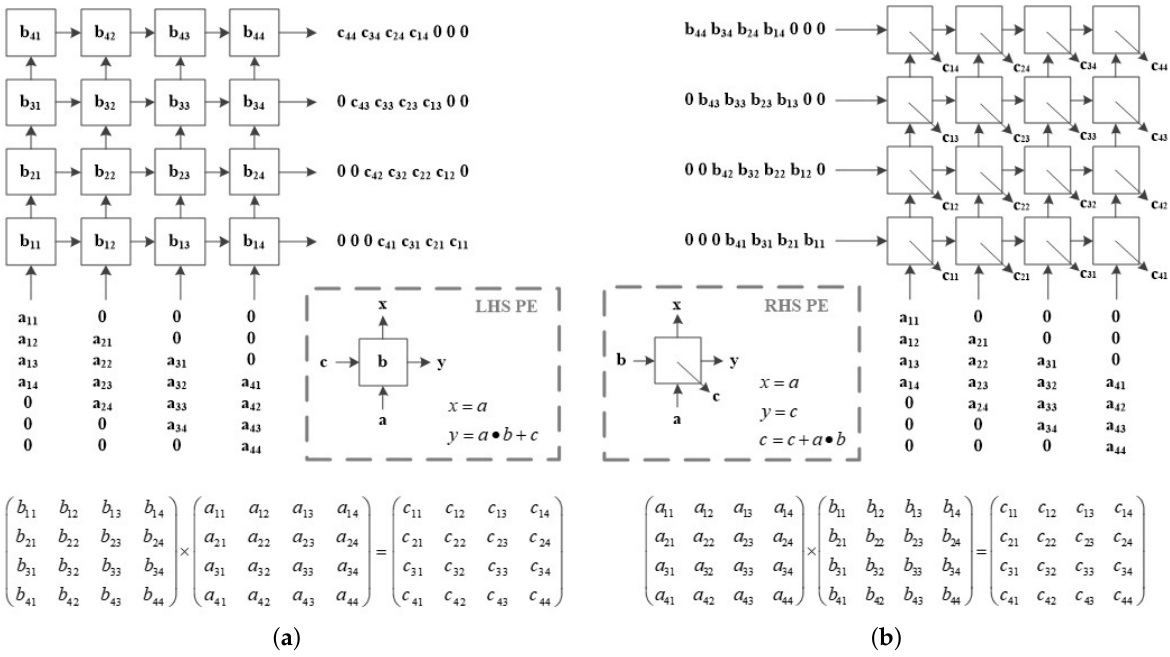
Figure 7. Systolic Array Structure ( a ) LHS (Left Hand Side); ( b ) RHS (Right Hand